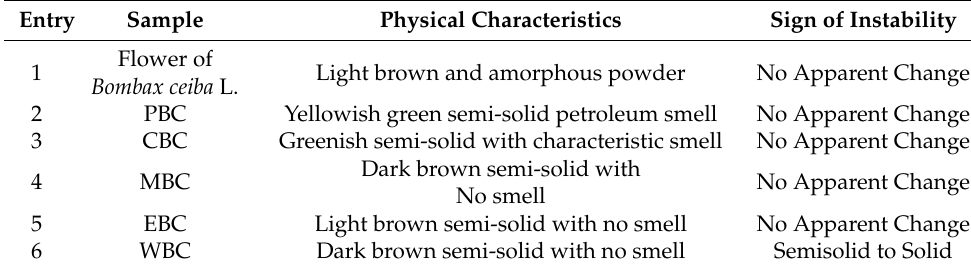
Table 2. Organoleptic properties of various extracts of flowers of Bombax ceiba